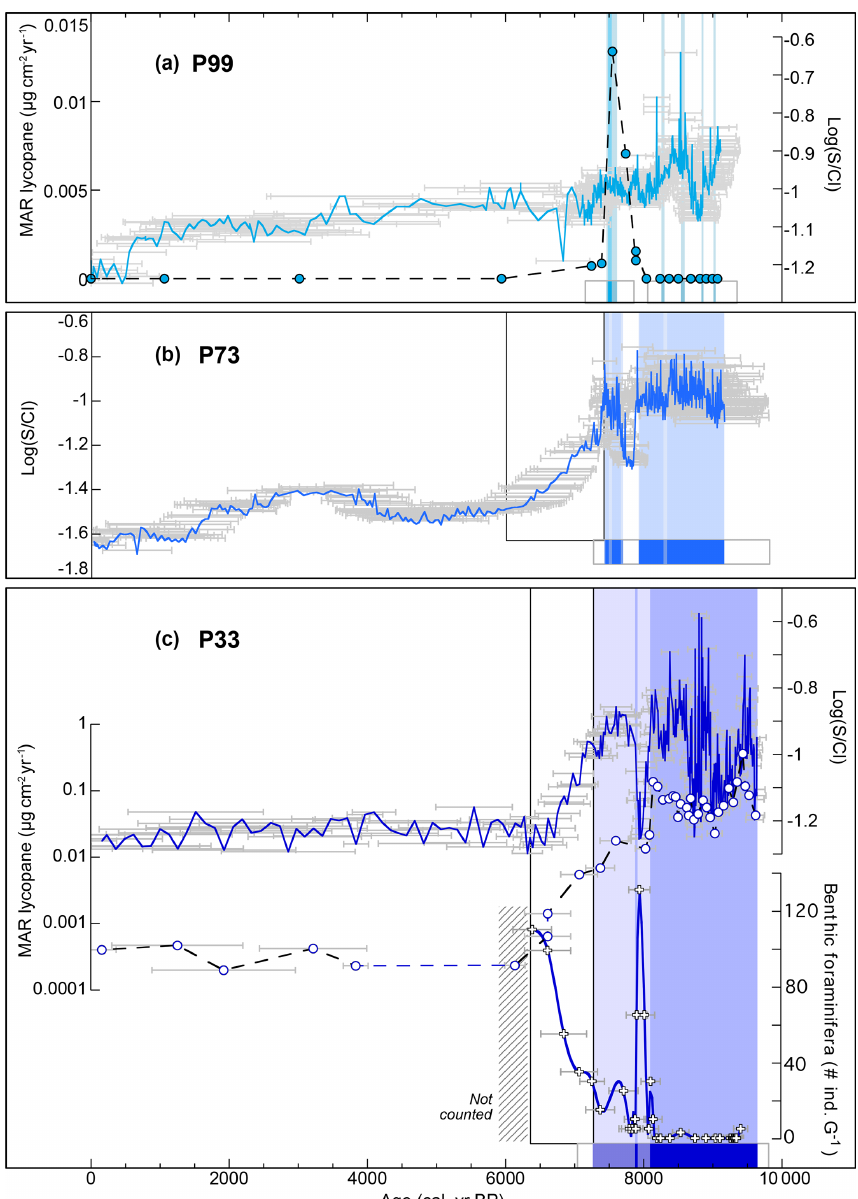
Figure 6. Proxies of paleo-oxygenation in cores (a) P99 (turquoise), (b) P73 (blue) and (c) P33 (dark blue) on an age scale (0–10kaBP). For each core, from top to bottom: Log ratio of S / Cl (continuous lines), mass accumulation rates (MAR) of lycopane in P99 and P33 (dashed lines and circles), lamination pattern (darker boxes: laminated, lighter boxes: faint laminations). For P33: bottom curve shows the number of benthic foraminifera per g of sediment (white crosses and cubic spline as thick blue curve). Open boxes in P73 and P33: interval of gradual reoxygenation. Grey bars under each marker and around laminated intervals show the age